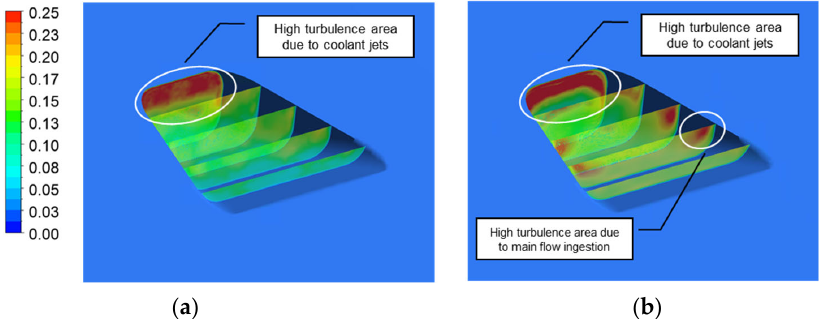
Energies 2021 , 14 , x FOR PEER REVIEW Figure 16. Characteristic turbulence intensity inside the cooling hole ( a ) without and ( b ) with upstream turbulent boundary layer when the blowing ratio is 2.0.